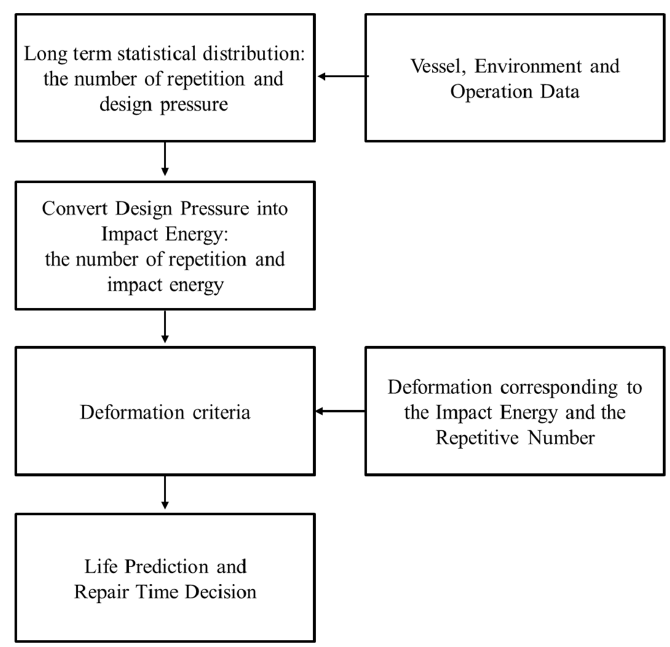
Figure 14. Life prediction scheme using the result of this study. Appl. Sci. 2019 , 9 , x FOR PEER REVIEW